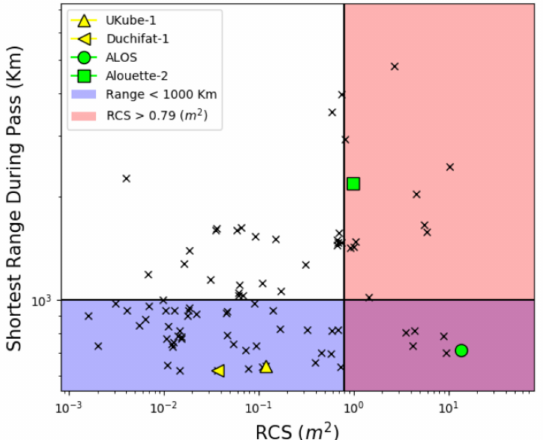
Figure 24. Range vs. RCS of satellite/debris detected by the MWA in late 2014 [66]. Copyright from Prabu, S.; Hancock, P.; Zhang, X.; Tingay, S. J. The Development of Non-coherent Passive Radar Techniques for Space Situational Awareness with the Murchison Widefield Array. Publications of the Astronomical Society of Australia 2020, 37, e010, reproduced with permission.